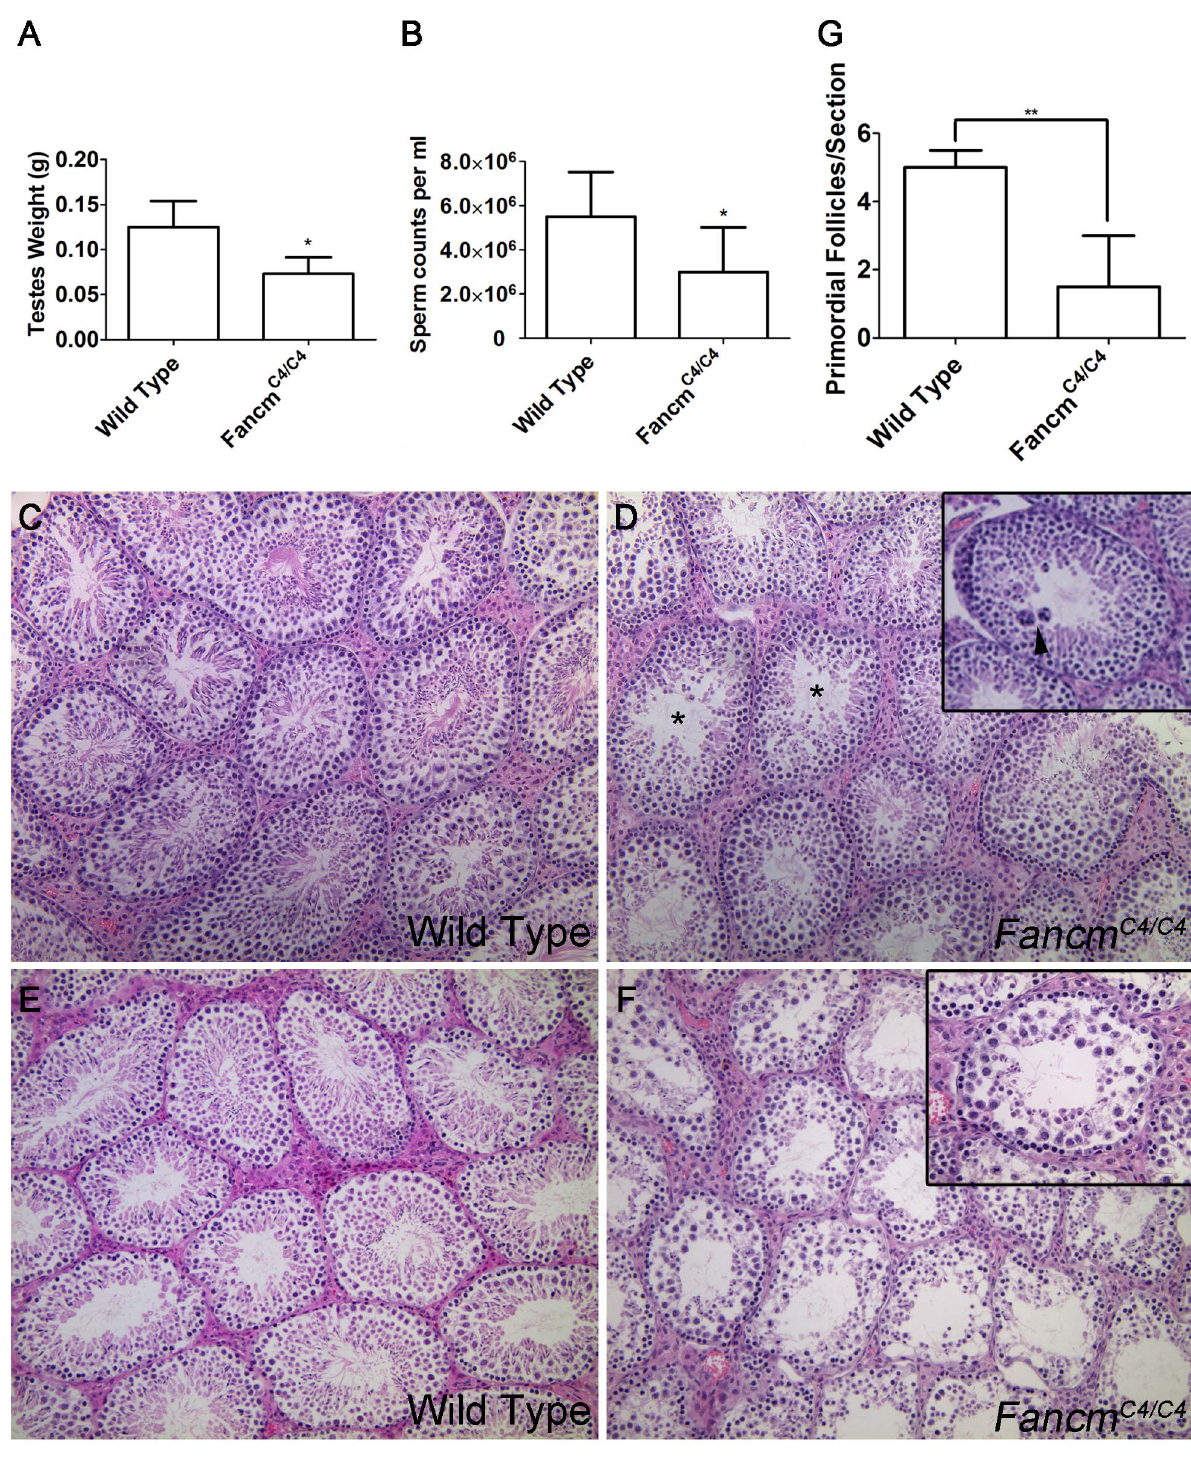
Figure 3. Hypogonadism and spermatogenesis defects in Fancm mutant males. (A,B) Fancm C4/C4 mice (12 weeks old) have smaller testes and lower epididymal sperm counts. (C–F) H&E-staining of testis sections of the indicated genotypes. Samples in panels C–D are from 16 week old males. Arrowhead points to a giant multinucleated cell. (*) indicates an example of a seminiferous tubule with abnormal spermatogenesis. Panels E and F are from 80-wk-old males. Most tubules in 80 week Fancm C4/C4 testes have only Sertoli cells. (G) Primordial follicles quantification in mutants. * p , 0.05, ** p , 0.01 n . 10 for each genotype.